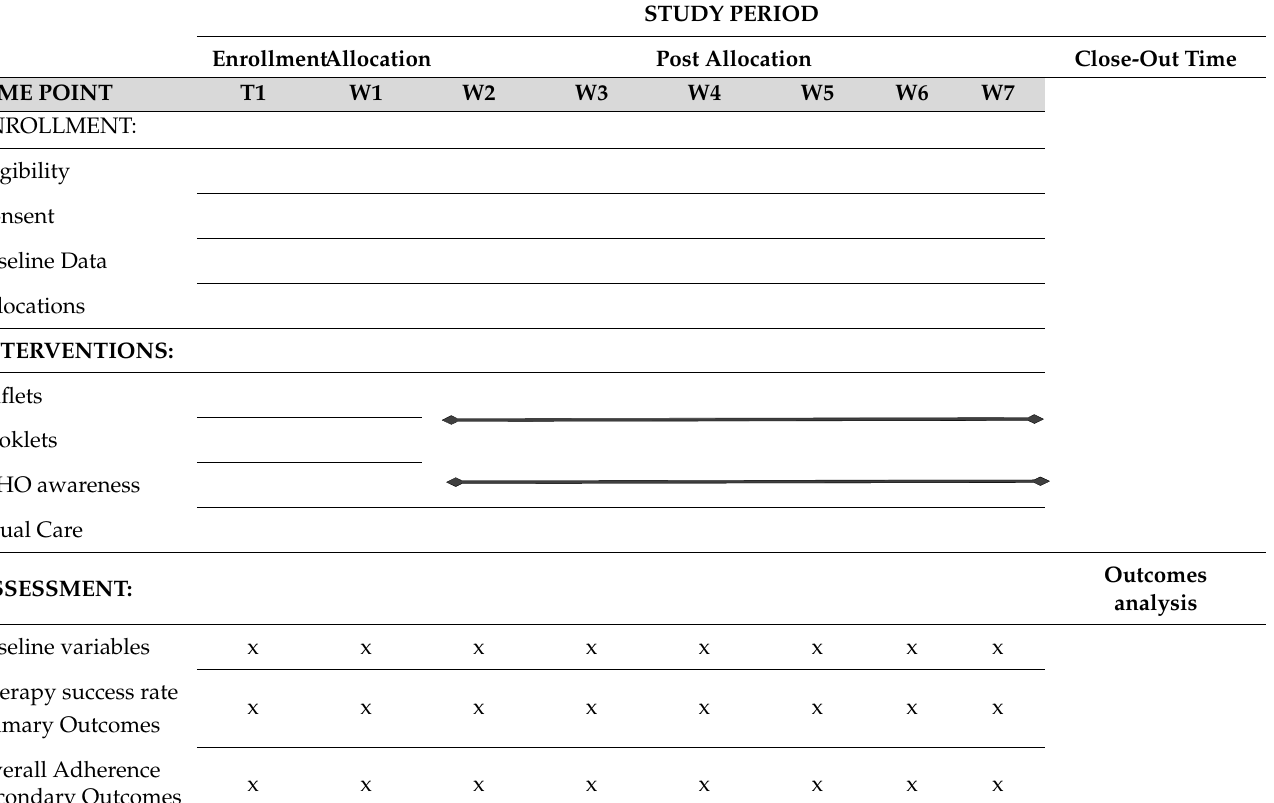
Table 2. Schedule of enrolment, interventions, and assessment; standard protocols items: recommendations for intervention trials (SPIRIT).